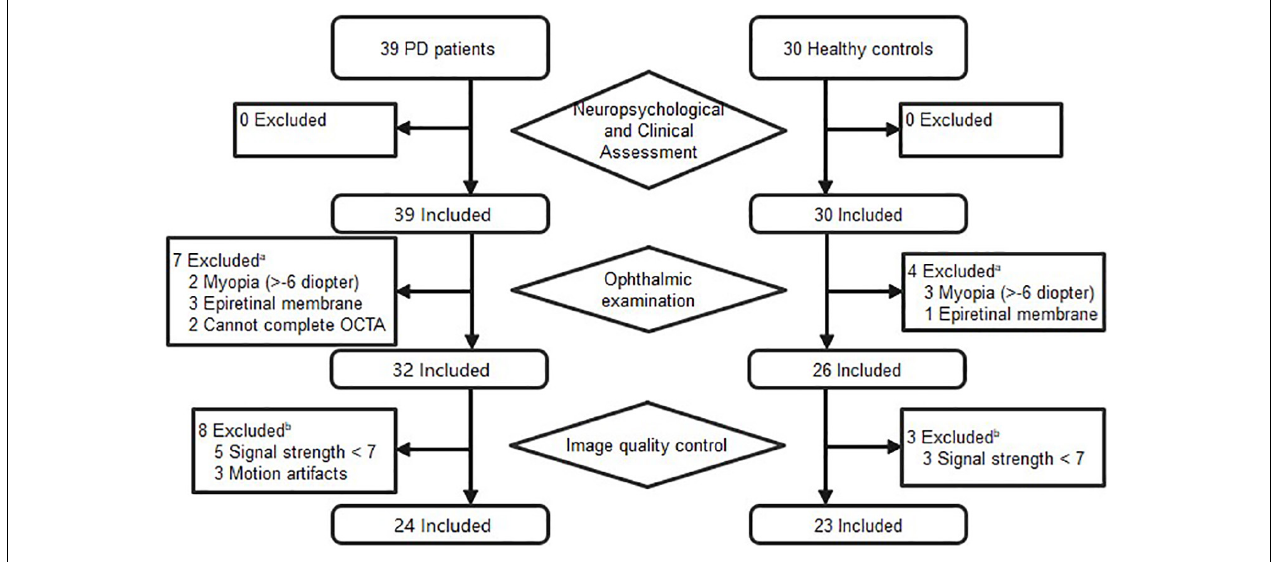
FIGURE 1 | Flow diagram of excluded subjects prior to analysis. a Patients were excluded if one eye had concomitant ocular diseases. b Patients were included if one eye’s images met the inclusion criteria.